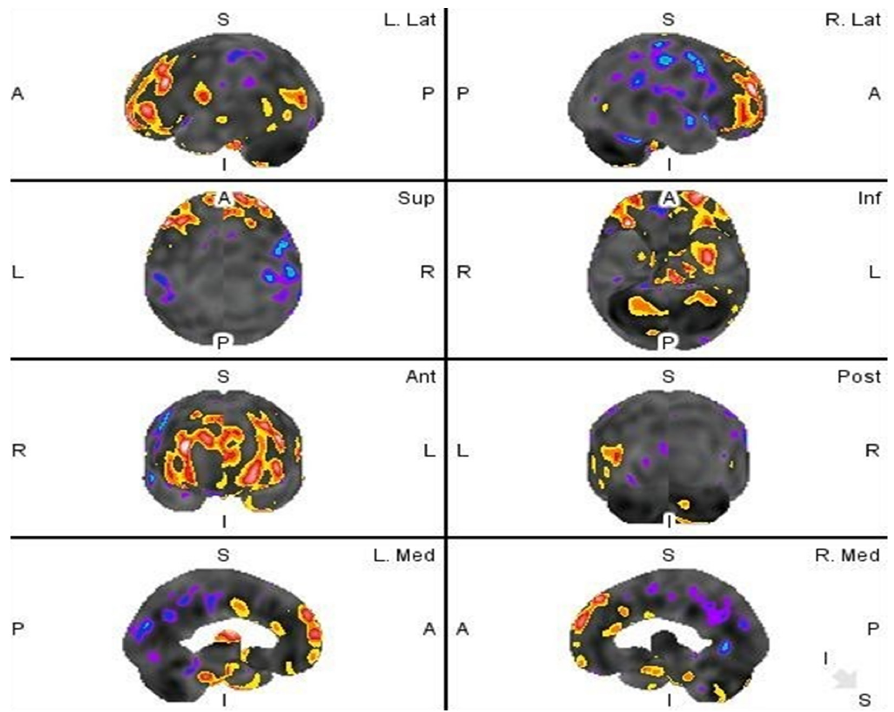
Figure 3. Two-tail Z score presentation of regions with statistically significant hypoperfusion (blue) and hyperperfusion (red). and hyperperfusion